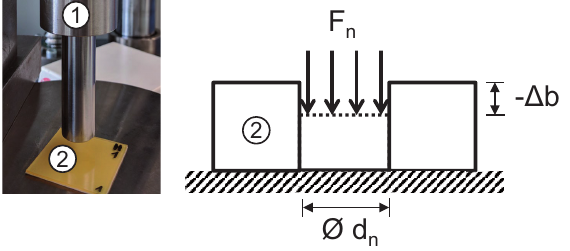
Figure 3. Experimental setup to determine the gap widening coefficient κ . A cylindric heading tool (1) with diameter d n is used to deform the printing plate (2) by − ∆ b . The applied force is F n .